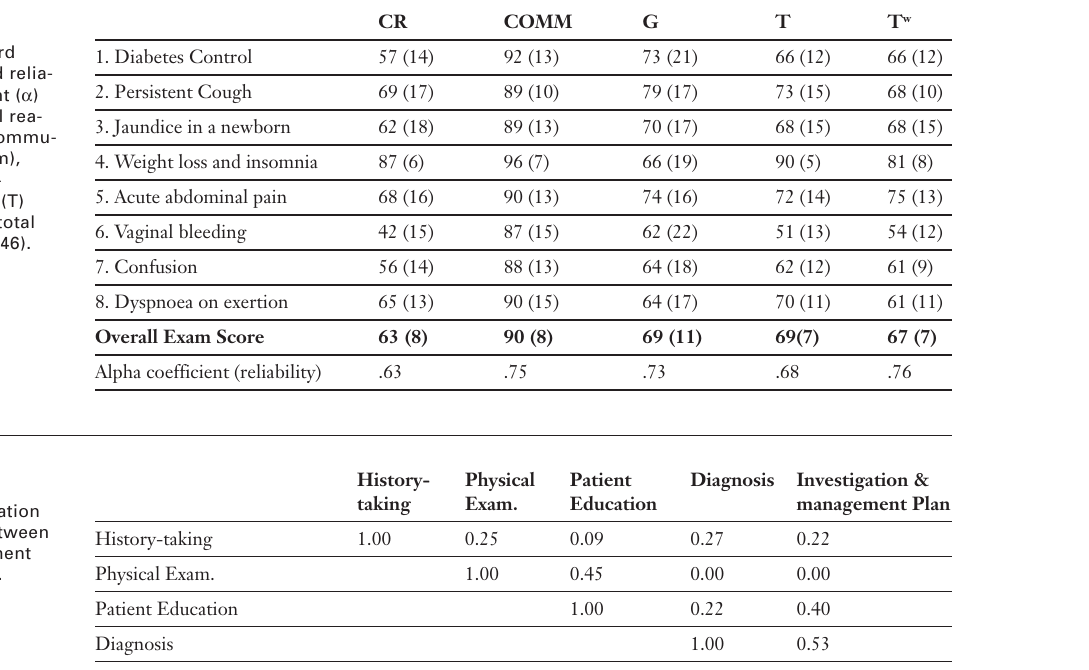
a Category total number of checklist items on the exam